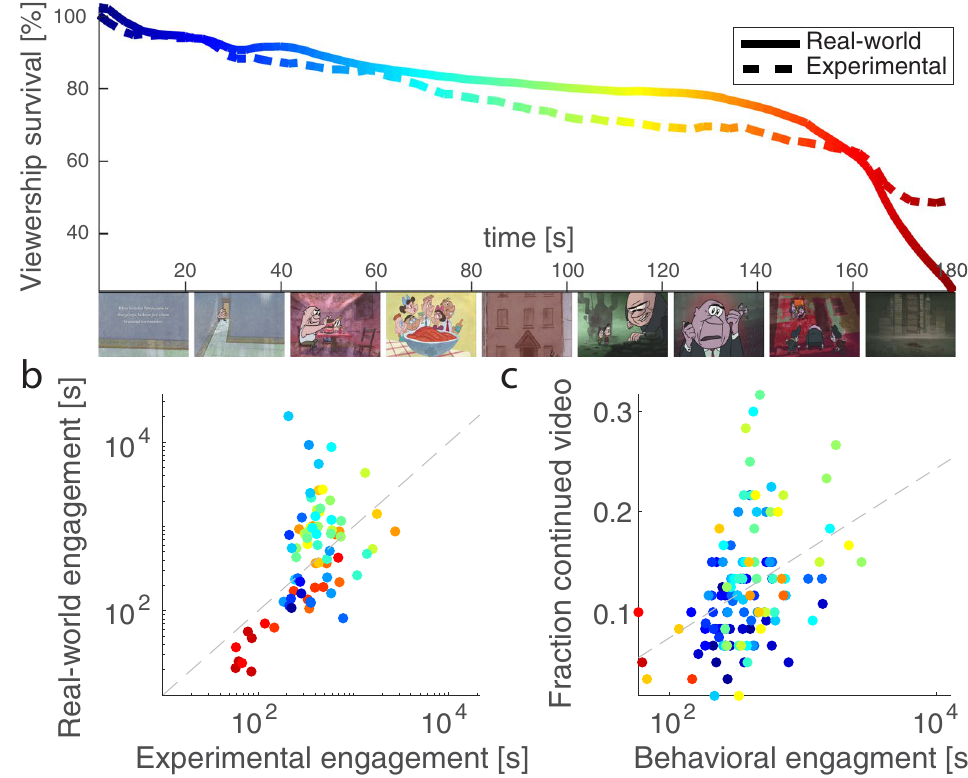
Figure 1. Behavioral engagement in “experimental” cohort mimics “real-world” behavior. ( a ) Viewership survival, shown for an example video, is measured as the fraction of the initial number of viewers who are retained over time. “Real-world” data (continuous line) was provided for this study by its content owner, StoryCorps, and represents the viewership (239,511 views) accumulated over several years for this video. “Experimental” survival (dashed line) was collected in approximately one hour from 1000 viewers recruited online via Amazon’s Mechanical Turk (MTurk) platform. ( b ) Variation in engagement across time correlates between real-world and experimental data (r = 0.60, p = 0.002, N = 77). Engagement was estimated using a time interval of ∆ t = 12 s for the five videos that were common to both conditions. Dashed line indicates points with equal engagement in both data-sets. ( c ) Experimental engagement correlated with the likelihood that a separate cohort of viewers voluntarily continued to watch the videos when given the option to stop. Dashed line represents the regression line. In both b and c each point represents a time interval, color represents the corresponding time point in the video from a, and engagement is displayed on a log-seconds scale. Still images from “Sundays at Rocco’s”, a StoryCorps animated short directed by the Rauch Brothers and produced by Lizzie Jacobs and Mike Rauch, reproduced here with permission from StoryCorps. We would additionally like to acknowledge StoryCorps for providing us with their YouTube analytics data and their animated interviews as video stimuli. These interviews were recorded by StoryCorps and are provided courtesy of